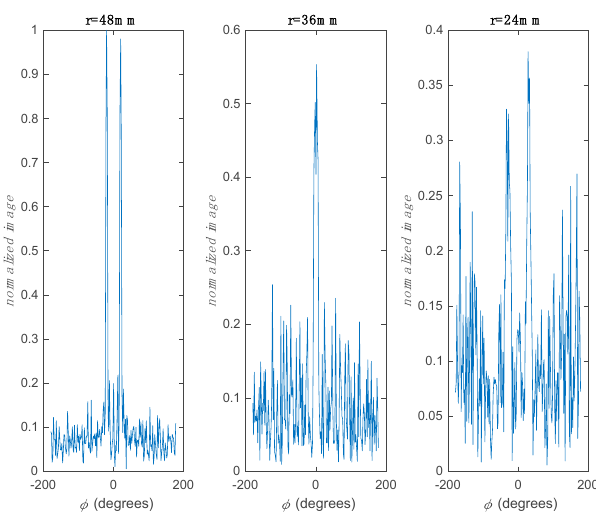
Figure 4. Normalized 2D reconstructed image of objects with side of D = 3 mm on three imaging circles with radii of 48, 36 and 24 mm using double frequency data collected by eight receiver antennas. On the inner circle with a radius of r 1 = 24 mm, two peaks are observed at ± 30